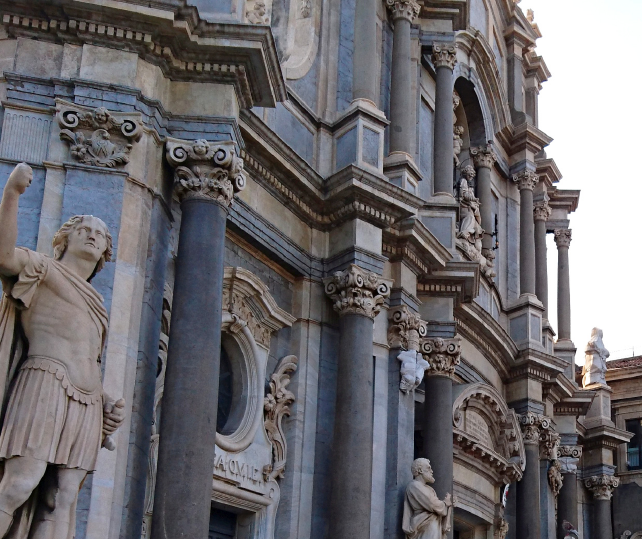
Figure 13. Distinctive colorful architrave introduced on façades and granite architrave in the Cathe- dral of S. Agata in Catania. Photo from private collection.